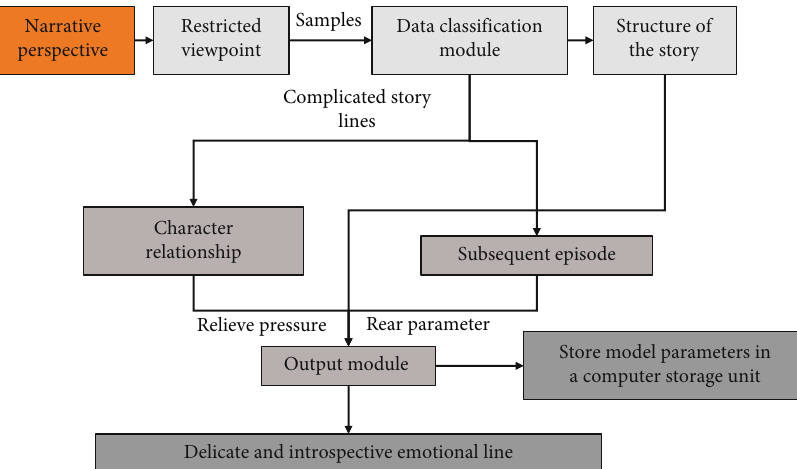
Figure 2: Linear narrative structure.